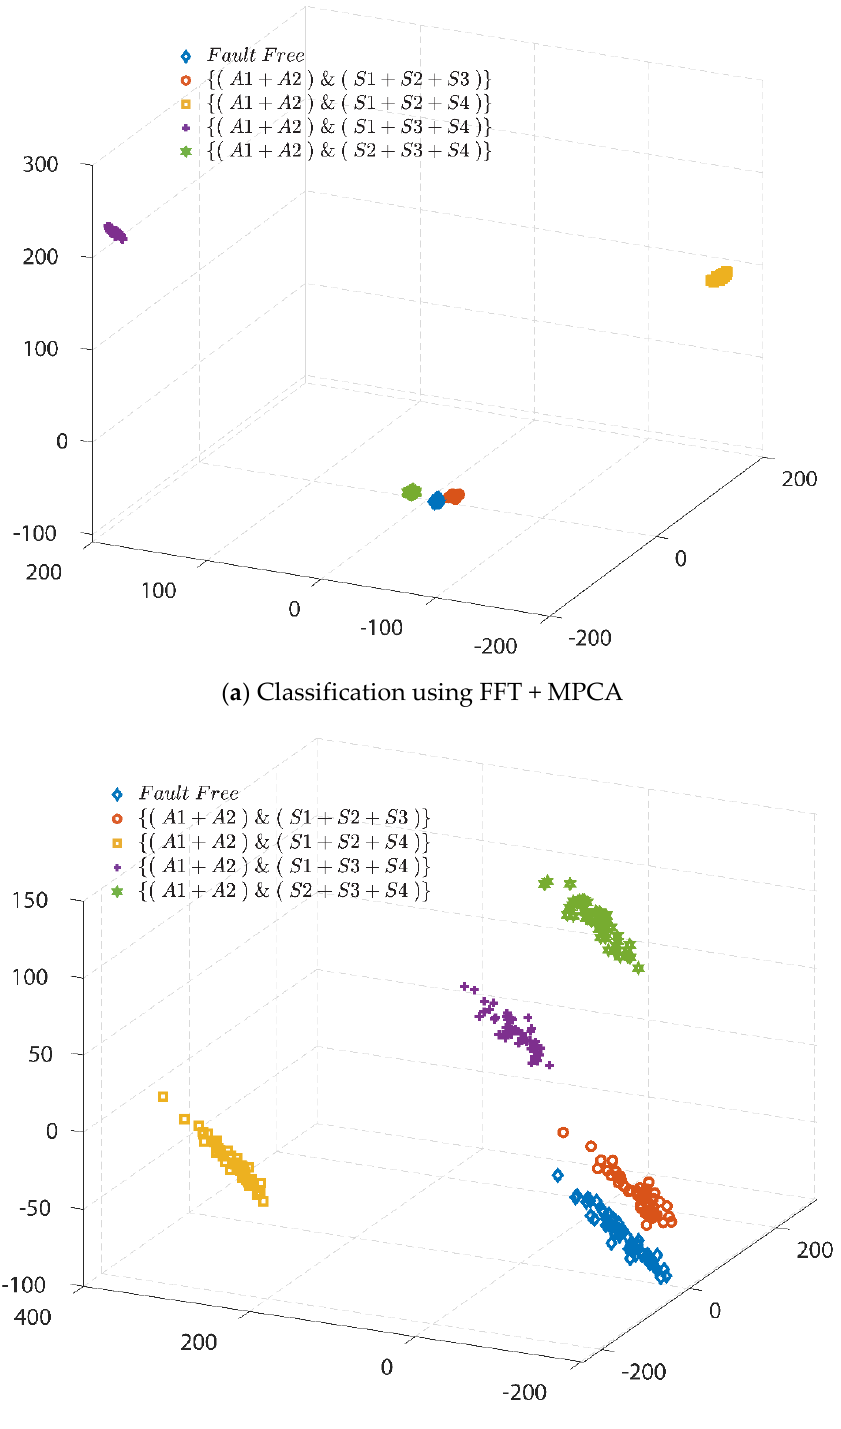
Figure 17. Three-dimensional space visualization performance for fault classification for wind turbines subjected to two actuator and three sensor faults under AWGN noises, ( a ) FFT + MPCA and ( b ) FFT + UMPCA, respectively.